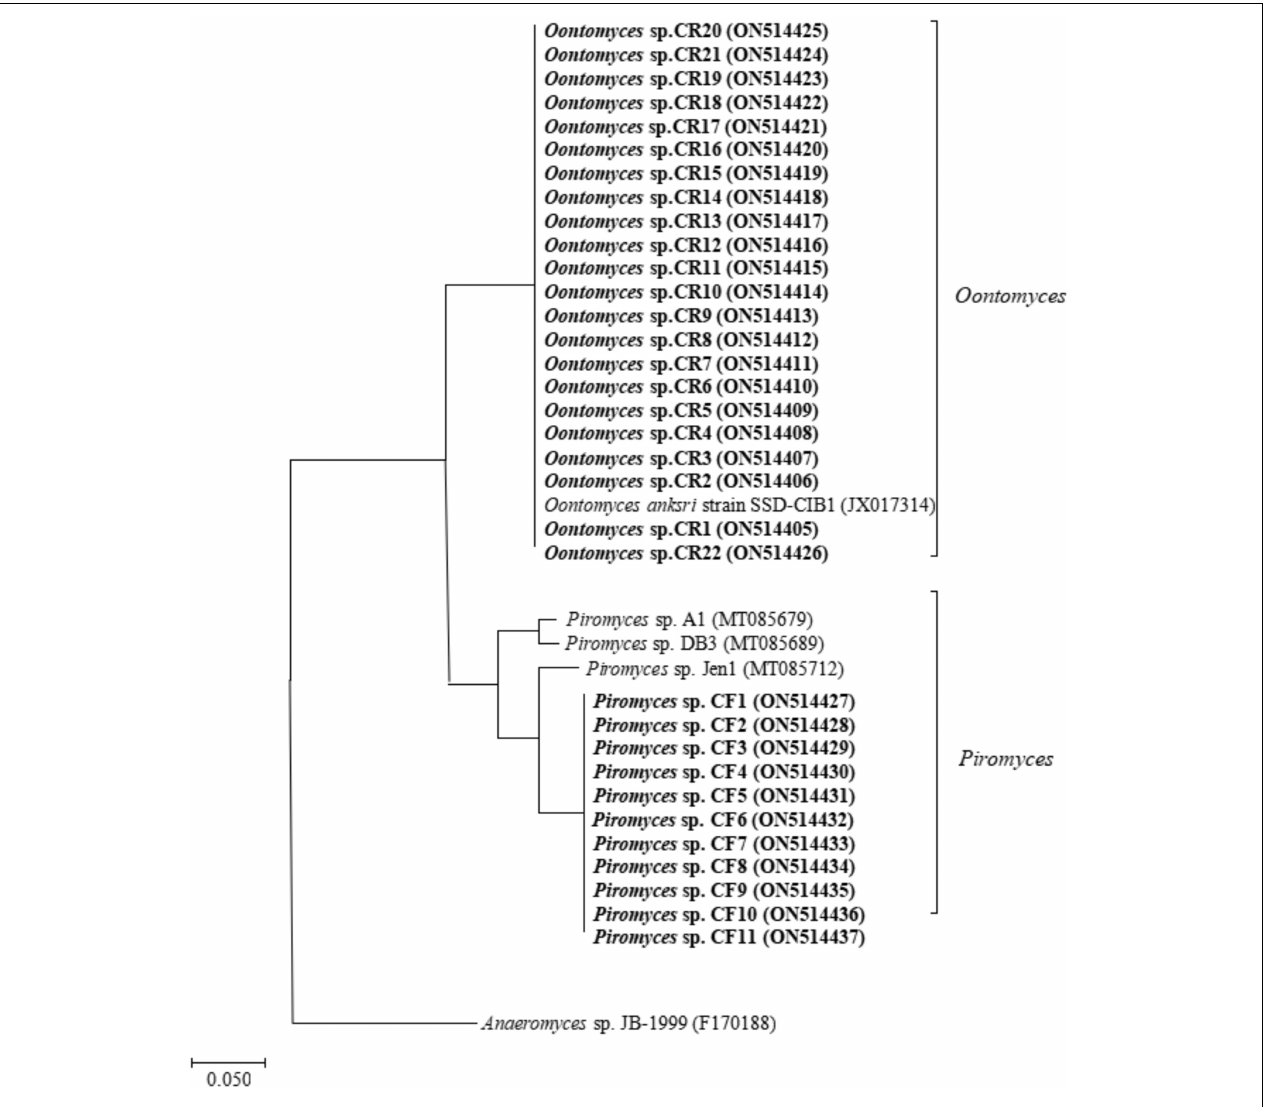
FIGURE 1 | The phylogenetic tree of ITS1 sequences of anaerobic fungal strains isolated from the rumen and feces of Junggar Bactrian